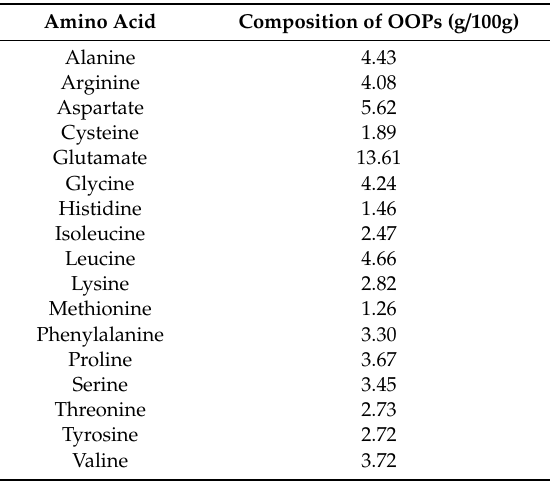
Table 1. Amino acid composition of